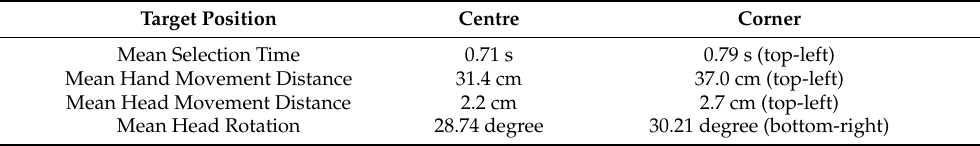
Table 2. The comparison of user performance measurements of the centre and corner target